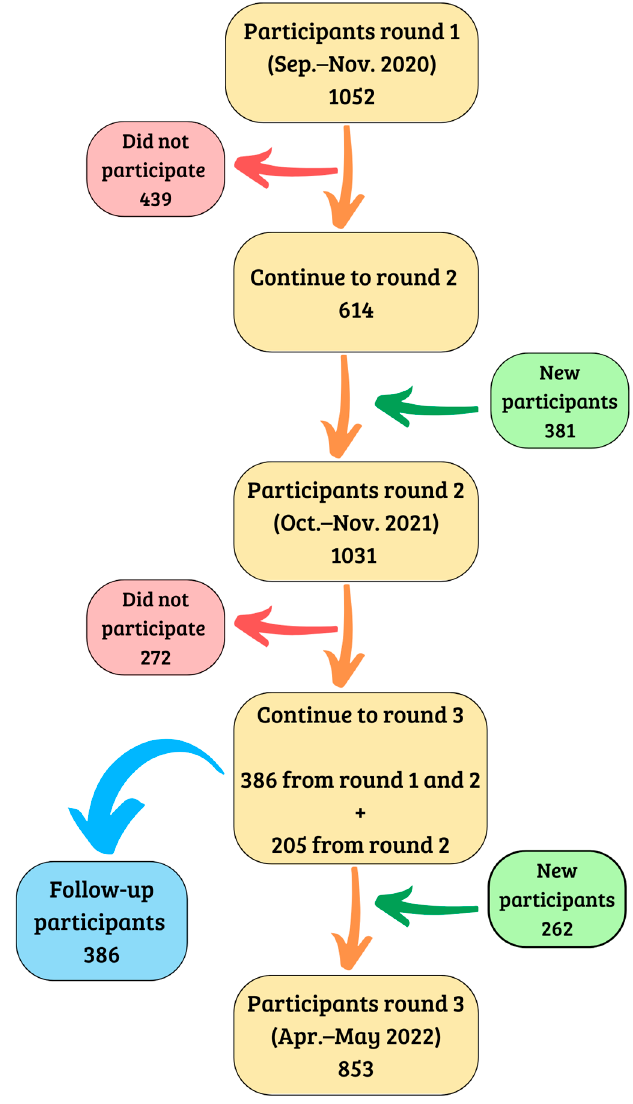
Figure 1. Scheme of the incorporation, loss and follow-up of the participants in the three rounds of the 2020–2022 seroprevalence